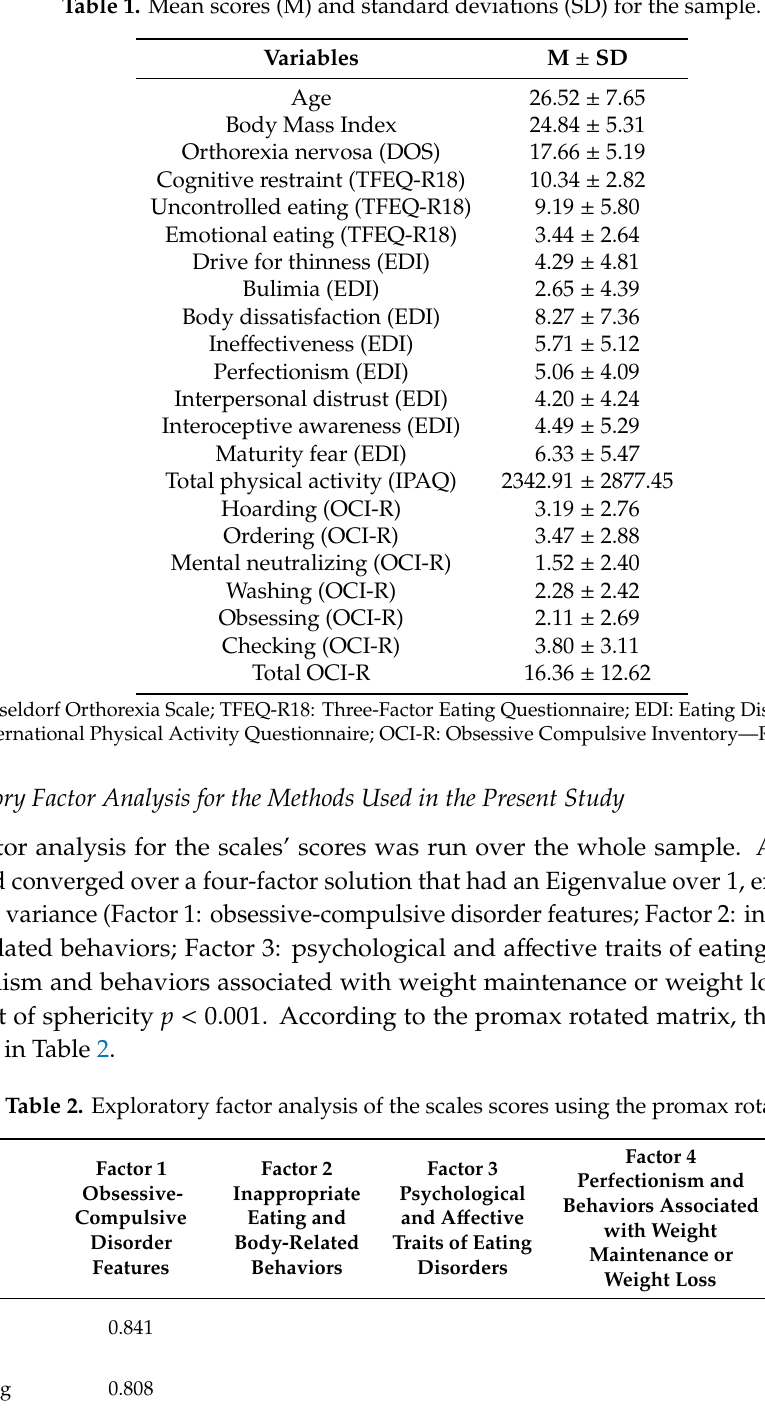
Table 1. Mean scores (M) and standard deviations (SD) for the sample.